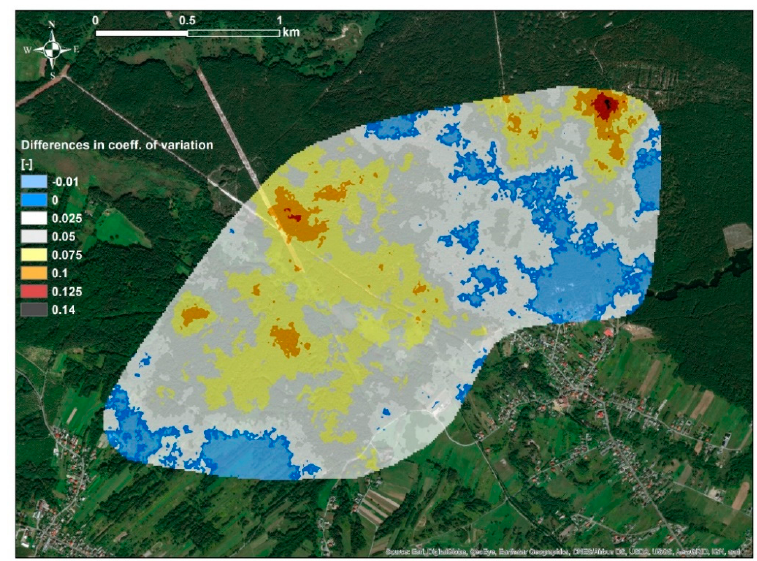
Figure 5. Spatial distribution of differences between coefficients of variation calculated using κ non-avg and κ avg data sets.